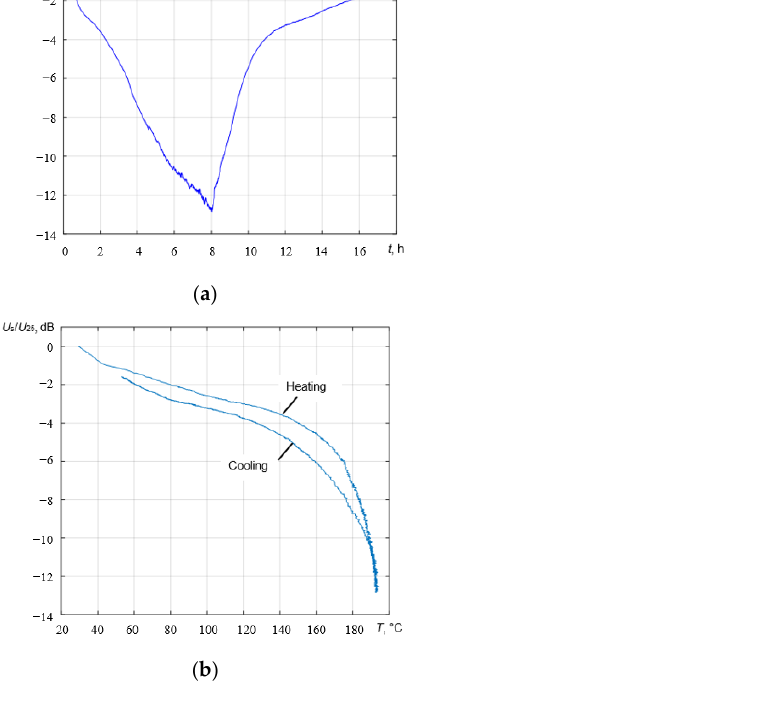
Figure 10. Signal amplitude. ( a ) Normalized amplitude of the reflected signal; ( b ) signal amplitude versus test block temperature. versus test block